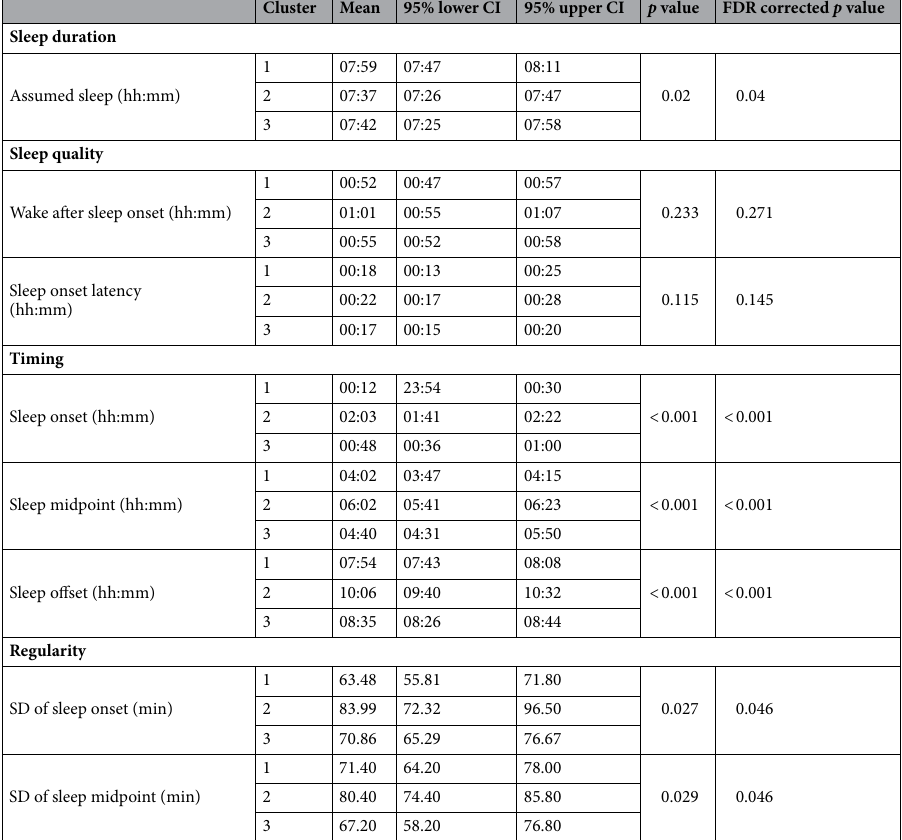
Table 3. Associations between clusters and sleep characteristics. Confidence intervals are calculated using bias corrected bootstrapping with 1000 bootstrapped resamples. False discovery rate corrected p values take account all omnibus analysis presented in